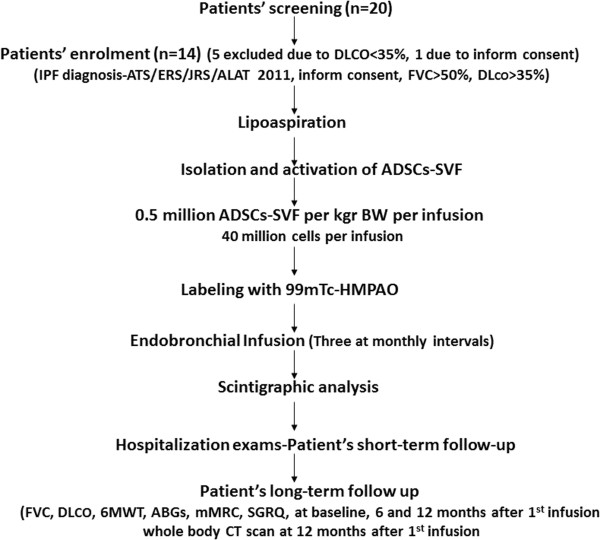
Schematic representation of the study protocol synopsis.